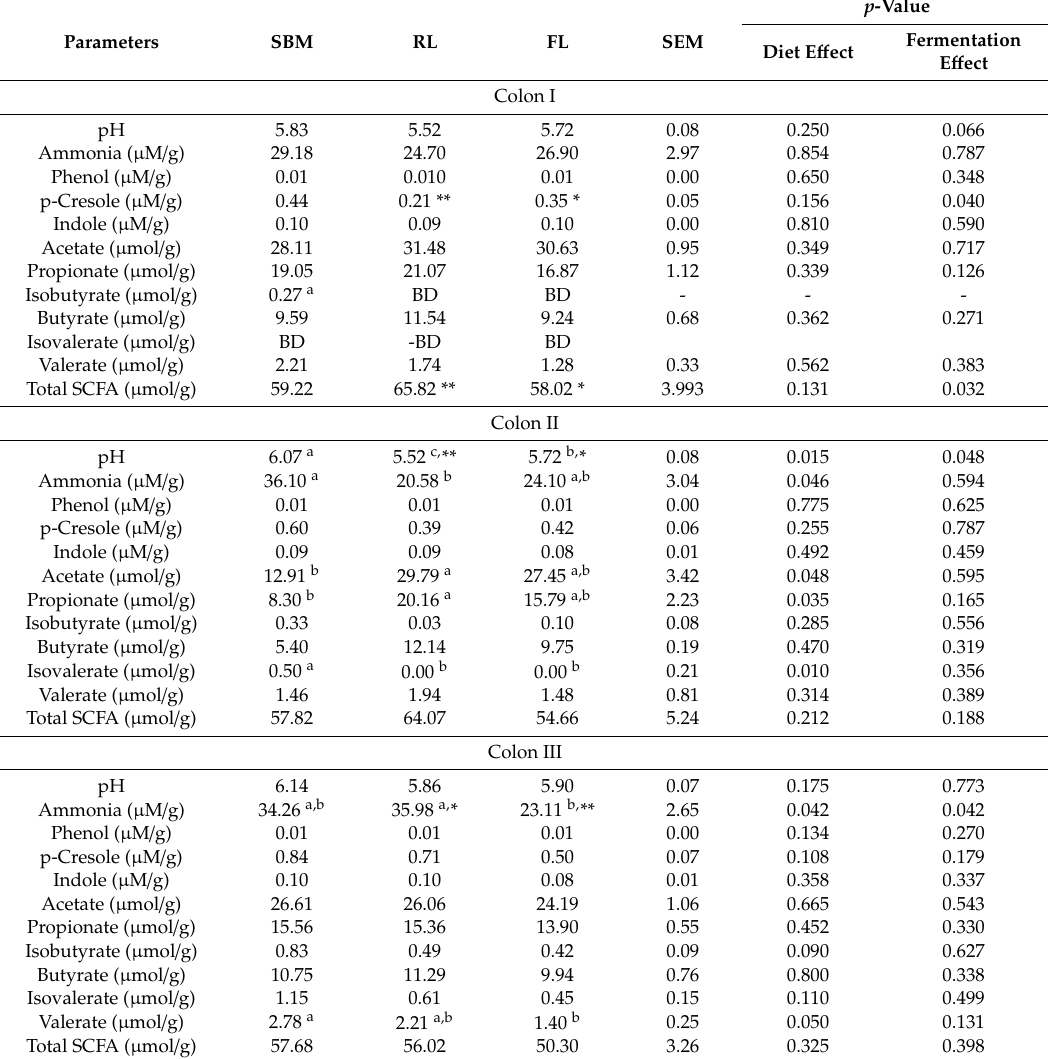
Table 5. Indicators of fermentation in fresh colon